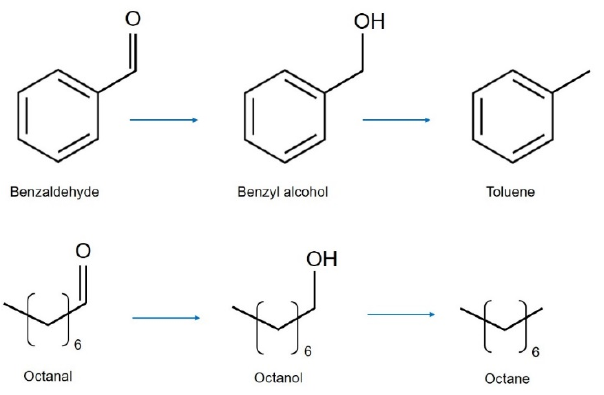
Figure 3. Reaction pathway of benzaldehyde ( top ) and octanal ( bottom ) hydrogenation/hydrogenolysis.